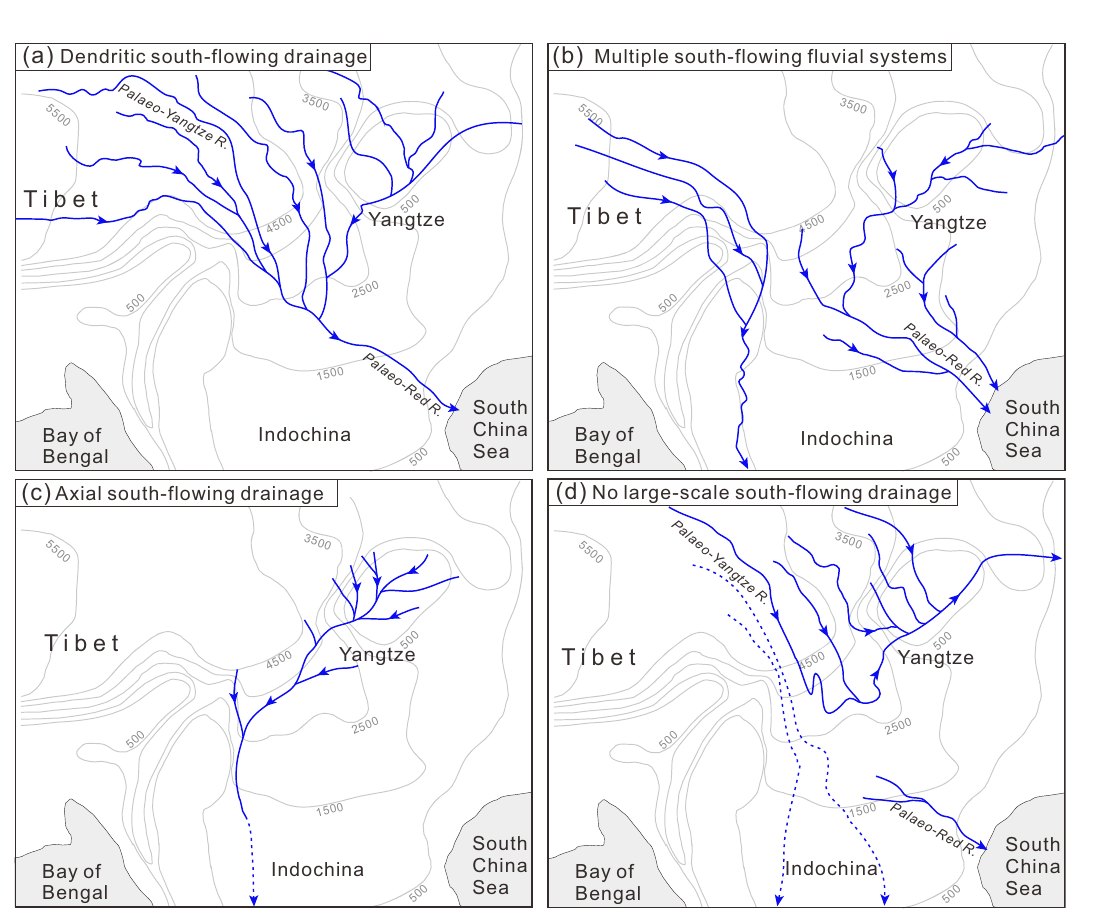
Fig. 2 Postulated drainage scenarios in SE Tibet before establishment of the modern river network. a Continental-scale, dendritic south- fl owing river system which drained into the South China Sea 6,15 . b A south- fl owing river system linking the Upper Yangtze terrane to the South China Sea 13 . c A south- fl owing transcontinental drainage that developed on the western South China Block 16 . d An east- fl owing river system similar to the modern drainage network, with no connection between the palaeo-Yangtze River and the palaeo-Red River 17,18 (or other south- fl owing